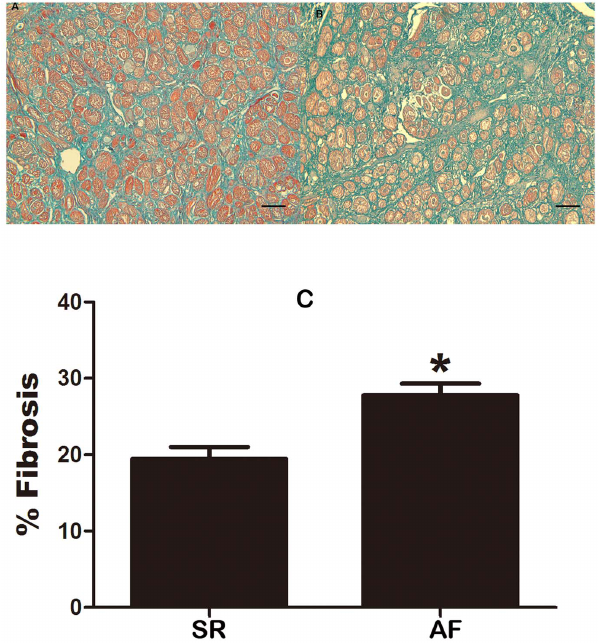
Figure 3. Comparison of atrial fibrosis between AF and SR subjects. A , Masson-Trichrome staining sections showing the distri- bution of fibrosis in AF. B , Masson-Trichrome staining sections showing the distribution of fibrosis in SR. C , Percentage of fibrotic tissues quantified based on the Masson-Trichrome staining using Image- ProPlus. Note that the proportion of fibrosis was considerably greater in AF subjects than in SR subjects. SR, sinus rhythm; AF, atrial fibrillation. * P , 0.001 vs. SR; n=10. Scale bar=100 m m. Magnification: 6 200.